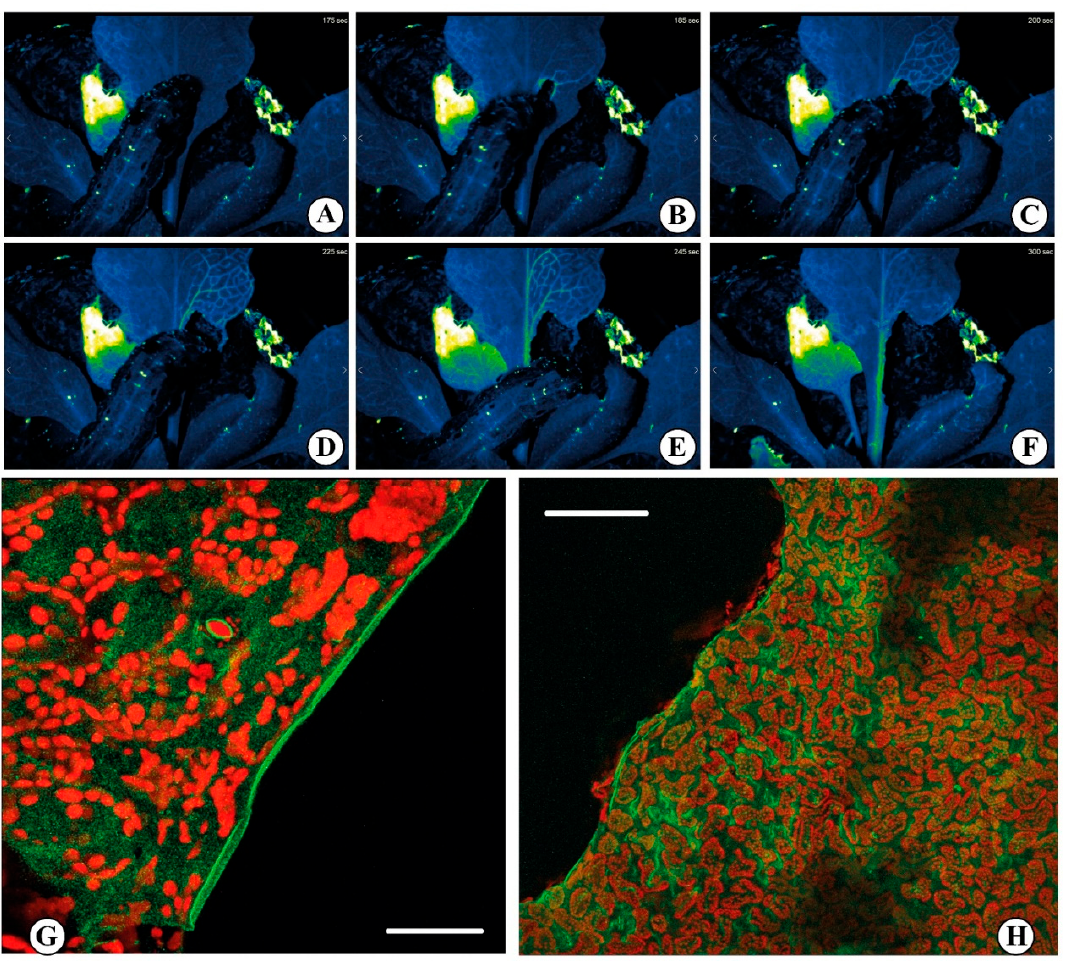
Figure 3. Calcium signaling upon herbivore feeding. ( A – F ) false colors time-course imaging of Ca 2+ release upon feeding with the insect Spodoptera littoralis on a rosette leaf of Arabidopsis thaliana expressing the biosensor R-GECO1. The rapid fluorescence variation (blue to green) indicates the increase in the cytosolic Ca 2+ concentration following the insect feeding. A wave of Ca 2+ is generated at the site of feeding and rapidly spreads through the vascular system. The acquisitions have been obtained by a fluorescence stereo microscope Nikon SMZ18 with a SHR PLAN APO 0.5X WD:71. Excitation light was produced by a fluorescent CoolLED pE-300 ultra at 580 nm. Images were collected with a Mono Camera Nikon DS-Fi3 camera. Exposure time was set to 1 sec with a resolution of 8 bit 1440 × 1024. Images were acquired every 5 sec (See also Video S1). ( G , H ) Confocal laser scanning micrographs showing the increased [Ca 2+ ] cyt in Lima bean ( Phaseolus lunatus ) leaves upon feeding by S. littoralis . The red fluorescence is associated to the chlorophyll present in the chloroplasts, whereas the green fluorescence indicates the cytosolic localization of Ca 2+ by the indicator Calcium Orange TM . Scale bars: G = 100 µm; H = 200 µm (Figures ( G , H ) by Massimo Maffei).